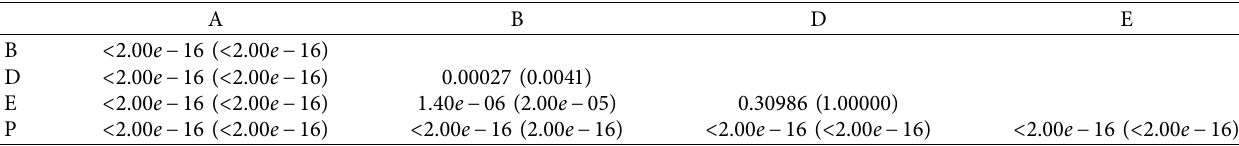
Table 9: In L-Space, for EMTnetwork, pI � 0.05, pR � 0.0025, and T � 150, p -value of in the Wilcoxon rank sum test (resultant p -value per Bonferroni correction is indicated in brackets).